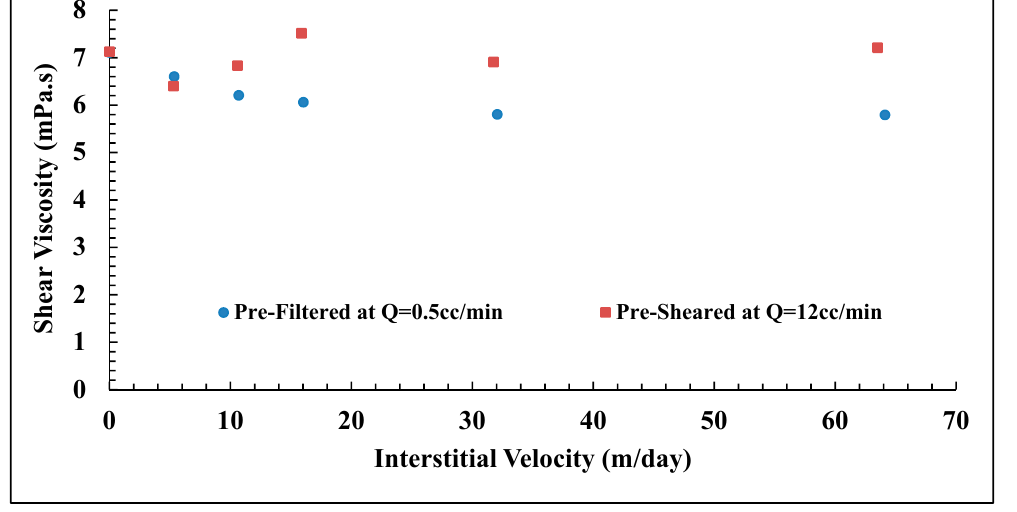
. γ = 10 s − 1 . Error bars are smaller than